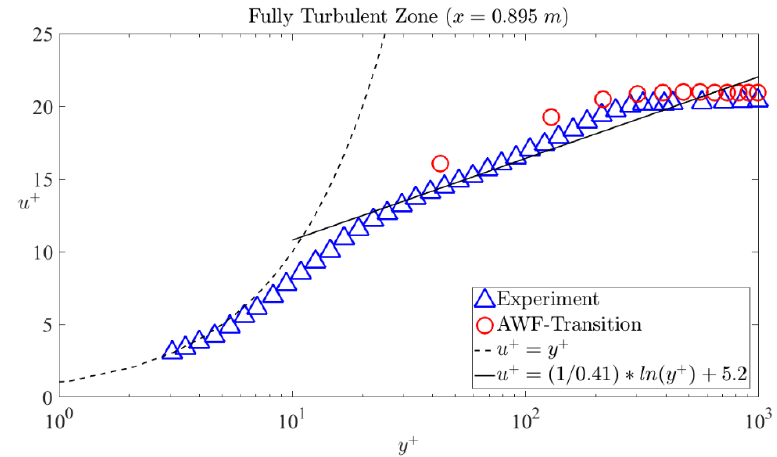
10 of 12 Figure 6. Velocity profile of T3A in the laminar zone. In Figure 7, the mean velocity profile at 𝑥 = 0.895⁡𝑚 in the fully turbulent zone is